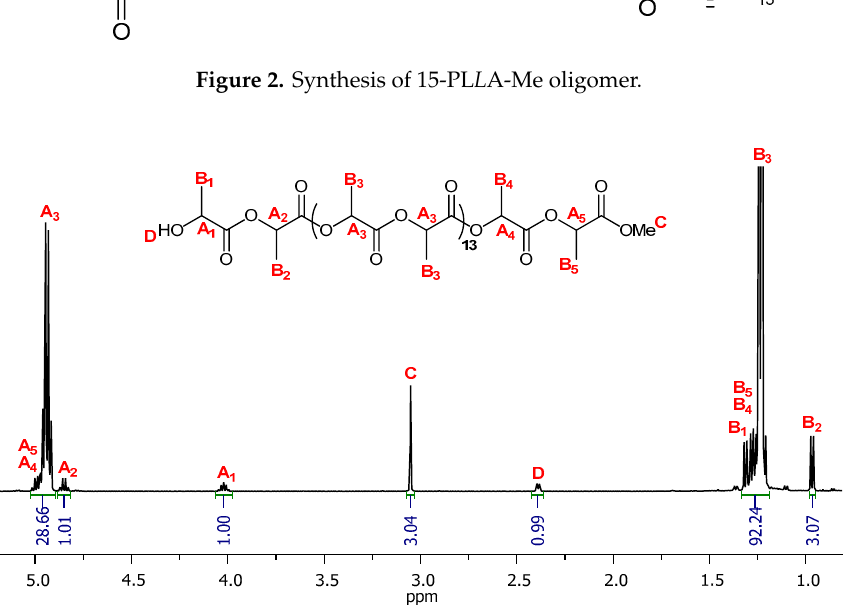
Figure 3. 1 H NMR spectrum of 15-PL L A-Me oligomer ( C 6 D 6 ).